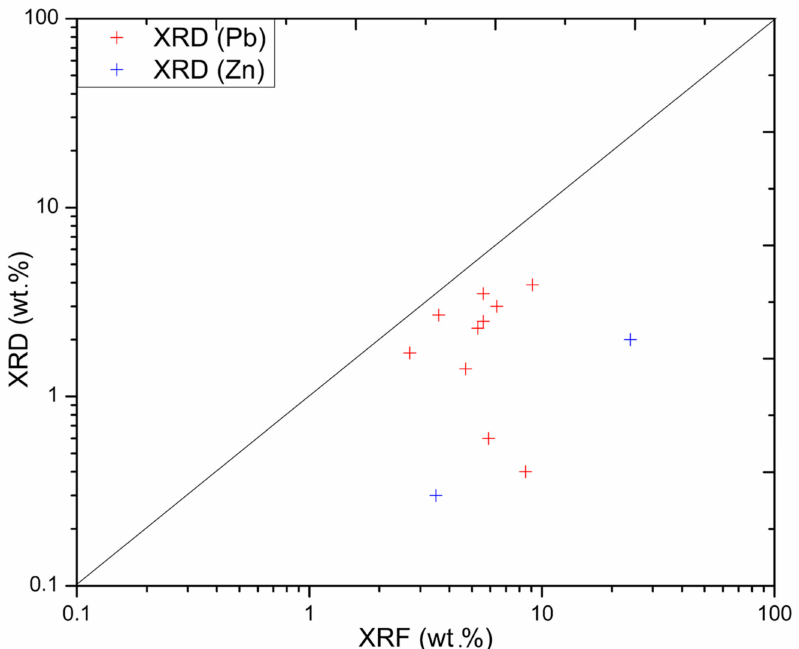
Figure 11. Scatter plot of Pb (red) and Zn (blue) values calculated from XRD versus the Pb and Zn values measured with XRF. Only samples where the Pb or Zn minerals were found were plotted. The underestimation of the Pb and Zn contents, based on XRD, are clearly